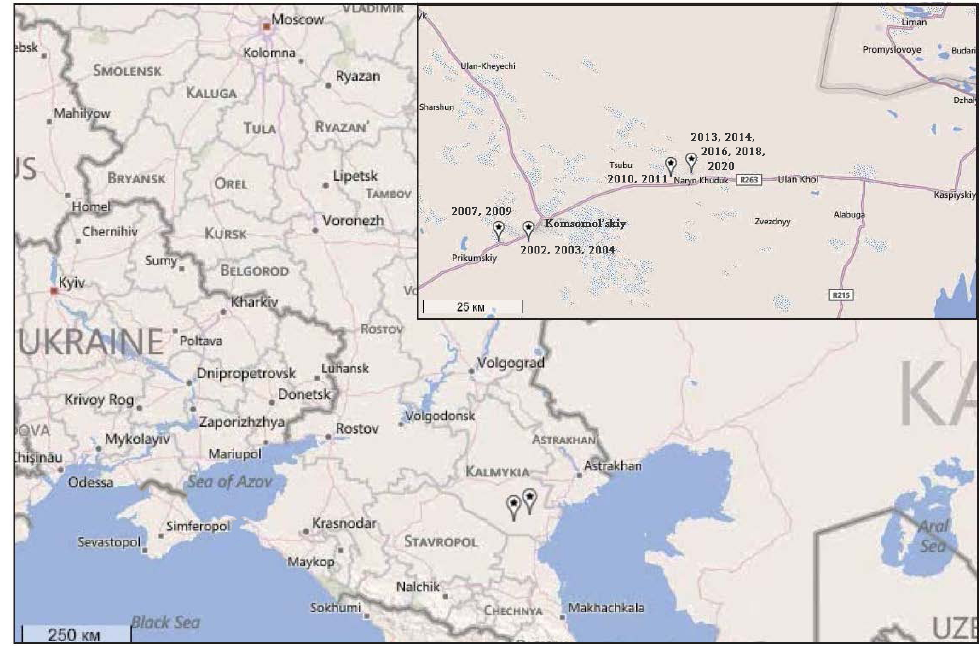
Figure 1. Map of experimental field observation stations (1–4) located in Kalmykia in 2002–2020. Description of the underlying surface (landscapes of Kalmykia and the Black Lands):